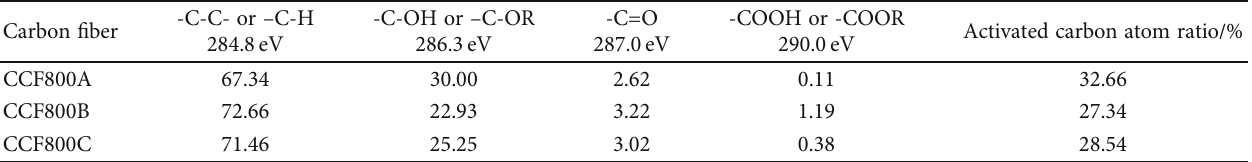
Table 4: The fi tting results of C1s